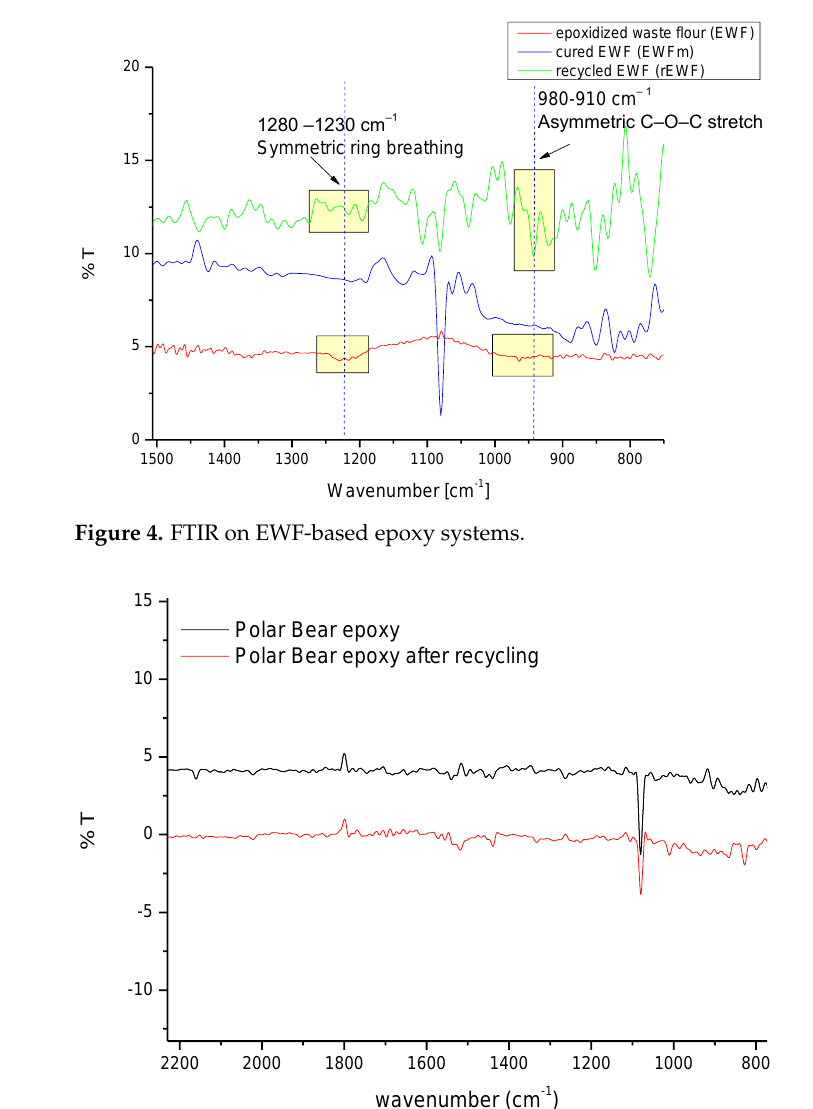
Figure 5. FTIR on Polar Bear TM systems